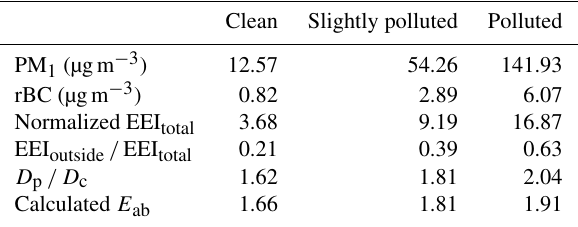
Table 1. The average PM 1 mass concentration, rBC mass con- centration, normalized EEI total , EEI outside / EEI total ratio, mass- averaged values of the D p /D c ratio and calculated E ab during clean, slightly polluted and polluted periods. EEI outside is the EEI of BC from areas outside Beijing; the EEI outside / EEI total ratio re- flects the amount of BC contributed by regional transport to the total amount of BC observed at our site. The clean (PM 2 . 5 ≤ 35µgm − 3 ), slightly polluted (35µgm − 3 <PM 2 . 5 ≤ 115µgm − 3 ) and polluted (PM 2 . 5 >115µgm − 3 ) periods were classified according to the Air Quality Index (Zheng et al.,